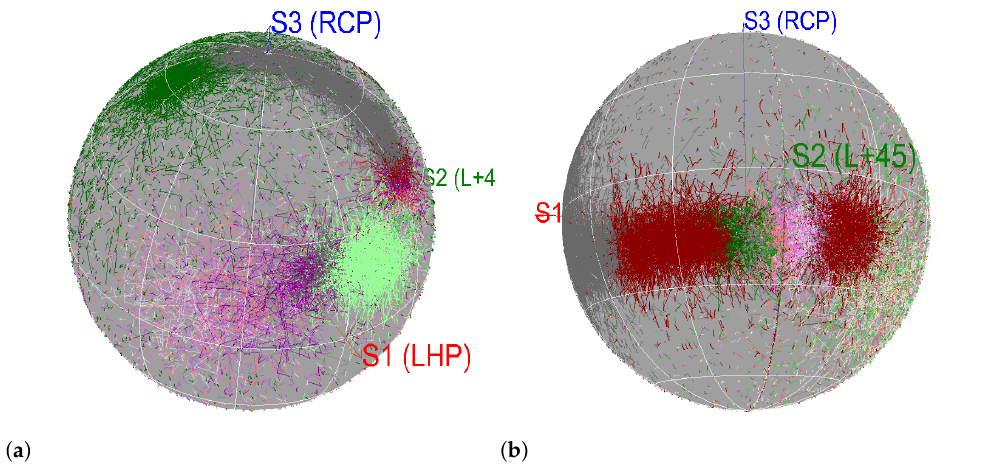
Figure 18. State of polarization after polarization demultiplexing OLT1 ( a ), OLT2 ( b